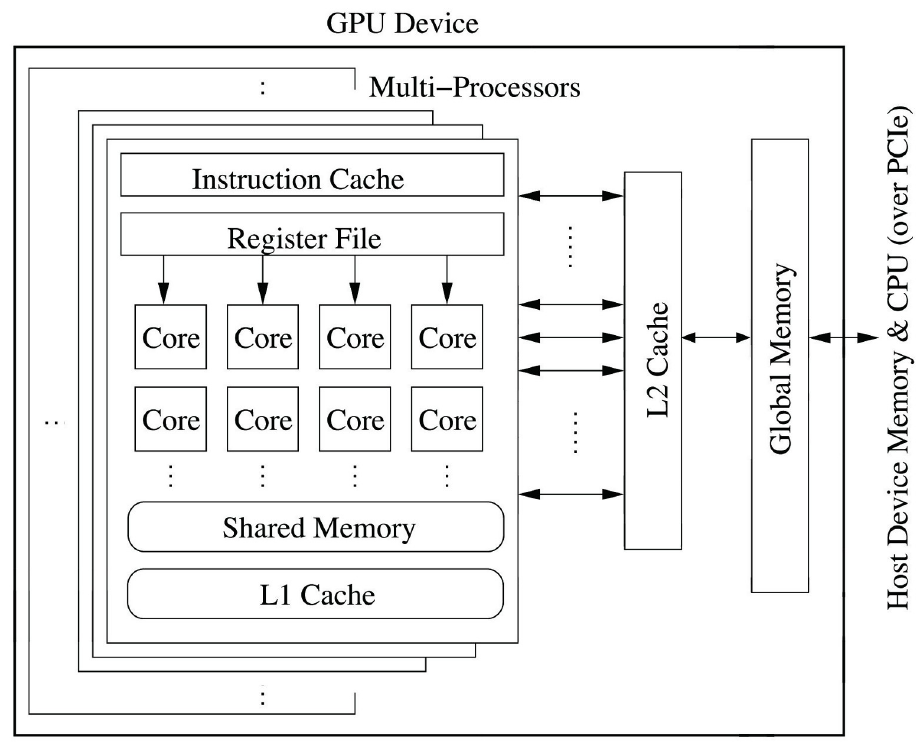
Fig 5. Architecture of a typical NVidia GPU